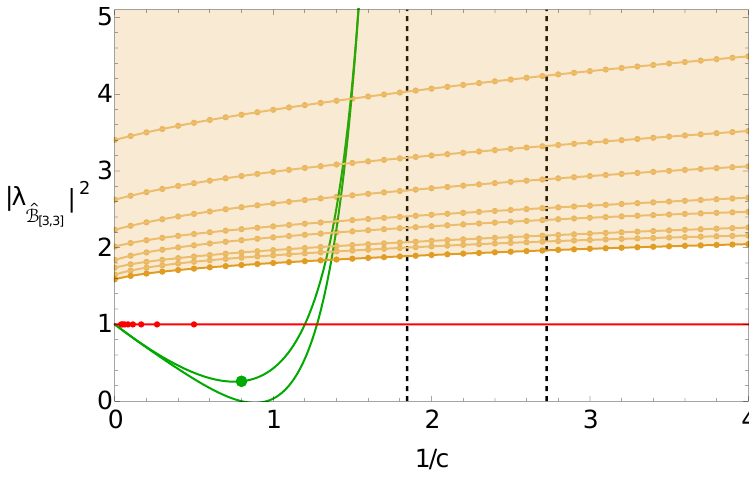
Figure 3 . Upper bound on the OPE coe(cid:14)cient squared of ^ B 1 =c . The shaded region is excluded and the number of derivatives is increased from 10 to 24 in steps of two. The two green curves show the possible value of the OPE coe(cid:14)cient computed by the chiral algebra in section 2.3, while the green dot shows the expected value for the N = 3 theory of 1 =c = 0 : 8, extracted from the chiral algebra of [11]. The red line and dots corresponds to the solution of N = 4 SYM theories. The two dashed lines correspond to the minimum central charges for an interacting N = 2 [47] and N = 3 SCFTs [75] ( c (cid:0) 1 = 30